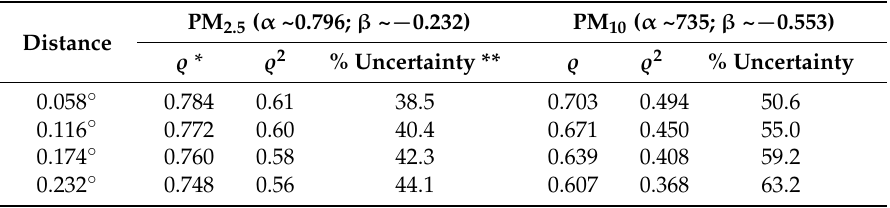
Table 3. Exposure uncertainty using the regression of PM autocorrelation with respect to different spatiotemporal